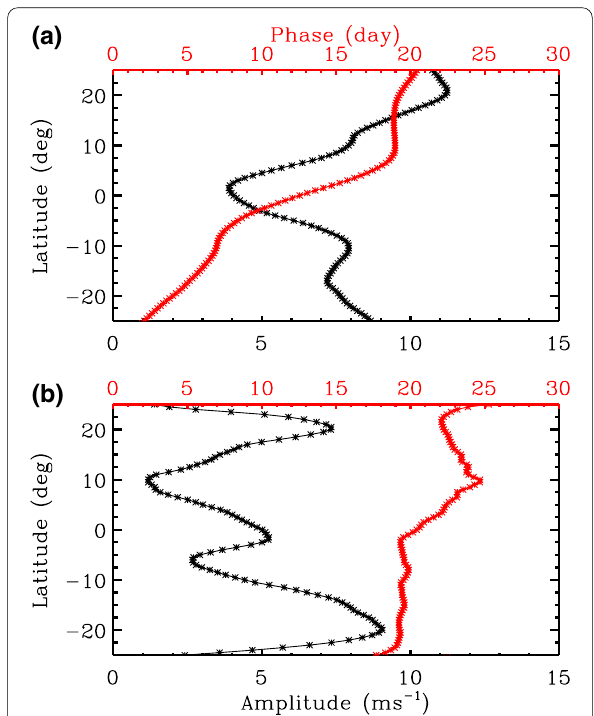
Fig. 7 Latitudinal evolutions of fitted amplitude and phase in zonal wind at a 0.48 hPa and b 176.93 hPa levels from MERRA-2 reanalysis data. The asterisk denotes the fitted